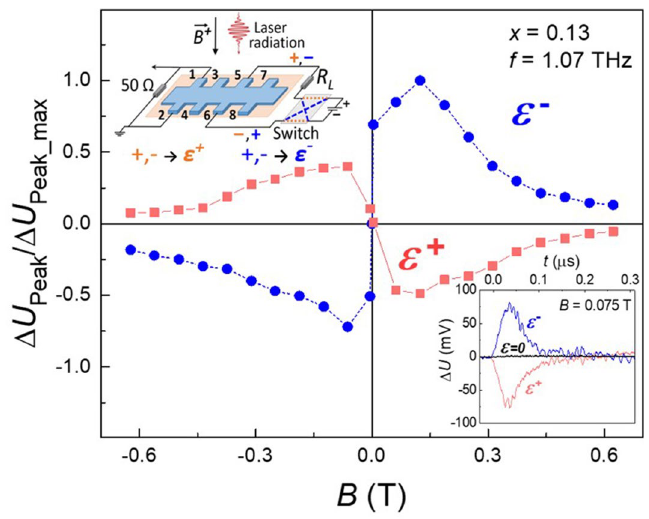
Figure 2. Magnetic field dependence of the photoresponse. The magnetic field dependence of the photosignal amplitude normalized to its maximal value taken using the configuration shown in the top inset. In the bottom inset: photocurrent kinetics taken at the zero bias, as well as for the two opposite electric bias polarities. ε + denotes the bias polarity marked by red “ + ” and “−”, while ε - implies the bias polarity marked by blue “ + ” and